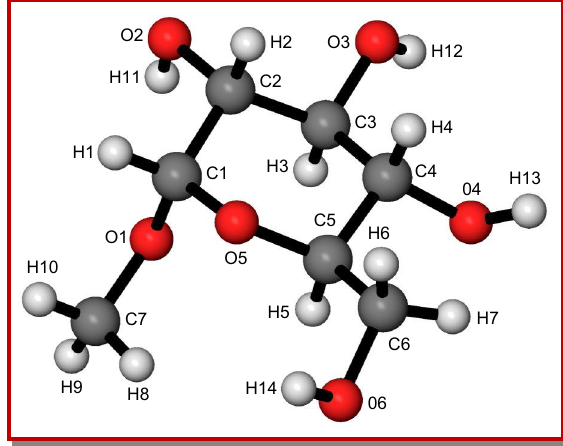
Figure 8: XRD crystal structure of methyl a-D-glucopyranoside (MDG) from Tv-7 sample of T. violacea